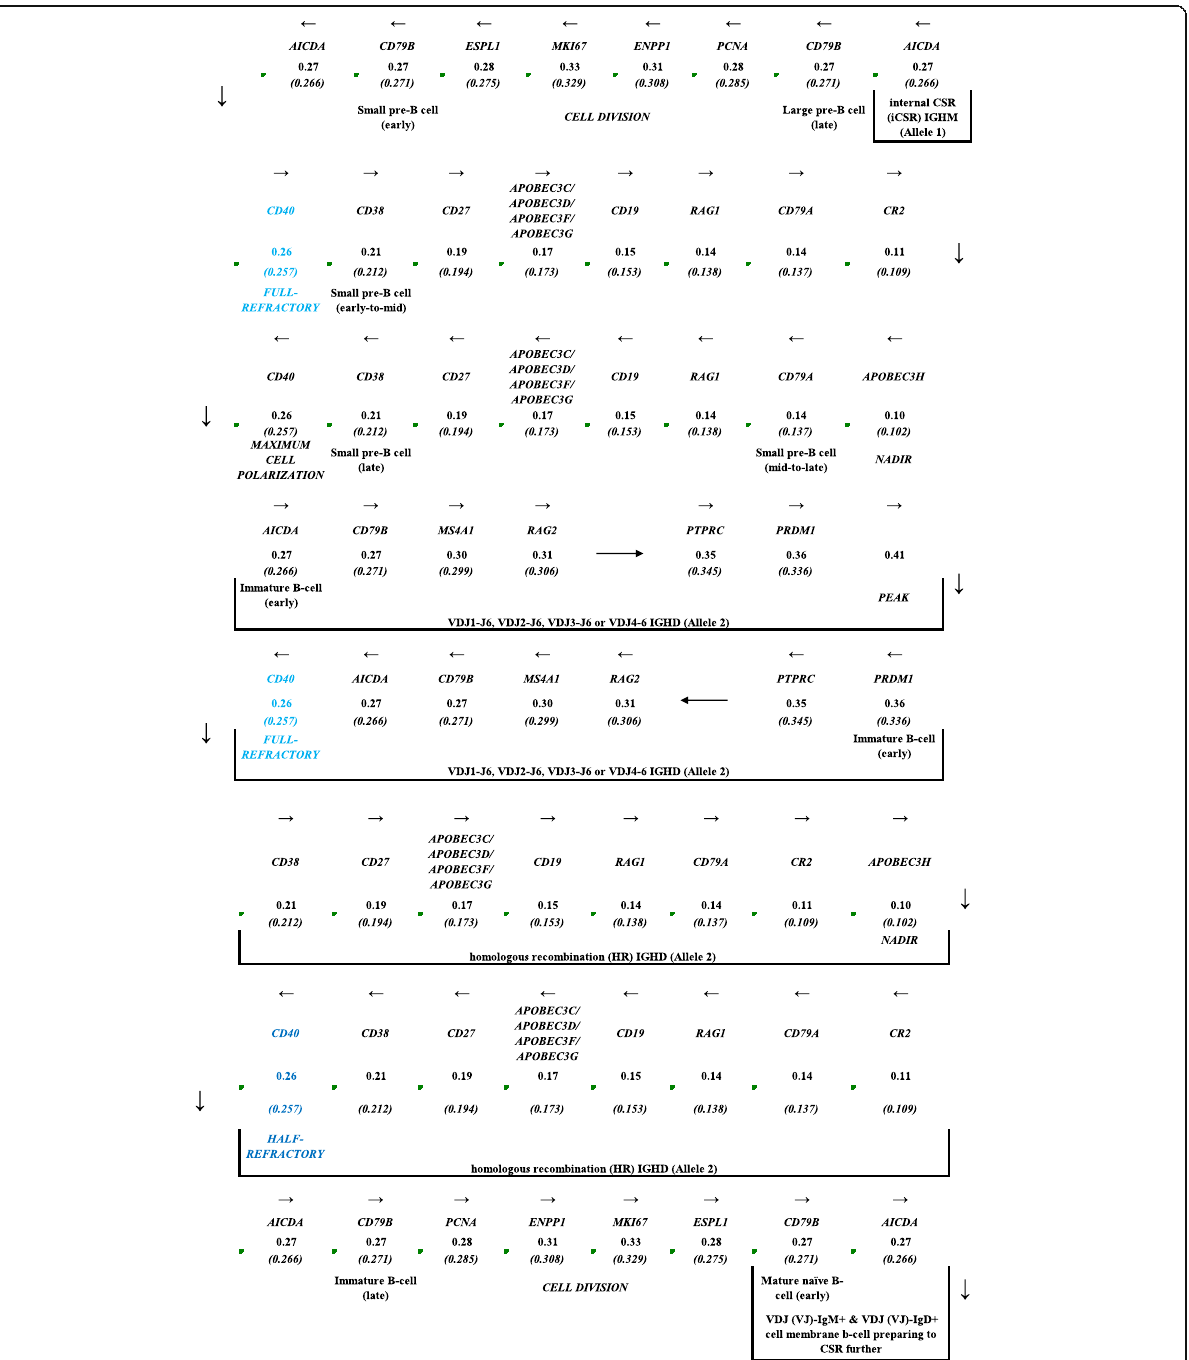
Fig. 1 Allele 1 (IGHM) 2-step and 1-step Ig heavy chain locus gene rearrangement recombination steps superimposed on the pressuromodulation map of B-cell differentiation stages. The Allele 1 two-step recombination steps are IGHD1 – 20 (nf) and IGHJ5 recombination (step 1 of 2), IGHD_-_ genes with respect to D1 – 20(nf)-J5 (step 2a of 2) and IGHJ6 with respect to D1 – 20(nf)-J5 (step 2a of 2) recombination that results that results in IGHD_-_ - IGHJ6 (step 2b of 2) through the final IGHV_-_ and IGHD_-_-IGHJ6 recombination that results in V_-_-DJ6 . The Allele 1 one-step recombination step is IGHD_-_ and IGHJ5 recombination that results in IGHD_-_ - IGHJ5 (step 1 of 1) through the final IGHV_-_ and IGHD_-_-J5 recombin- ation that results in V_-_-DJ6 . Note: Allele 1 locus rearrangement recombination steps complete to the point of the CM IgM+ B-cell before Allele 2 VDJ completes. † , upper esebssiwaagoT Q units range, 0.41 – 0.36. Black, CD40 at maximum cell polarization potential. Dark blue, CD40 at half-refractory. Light blue, CD40 at full-refractory. Text boxes with complete borders, 2-step. Text boxes with dashed borders, 1-step. Large rectangular box with complete borders, extra-nodal secretory antibody